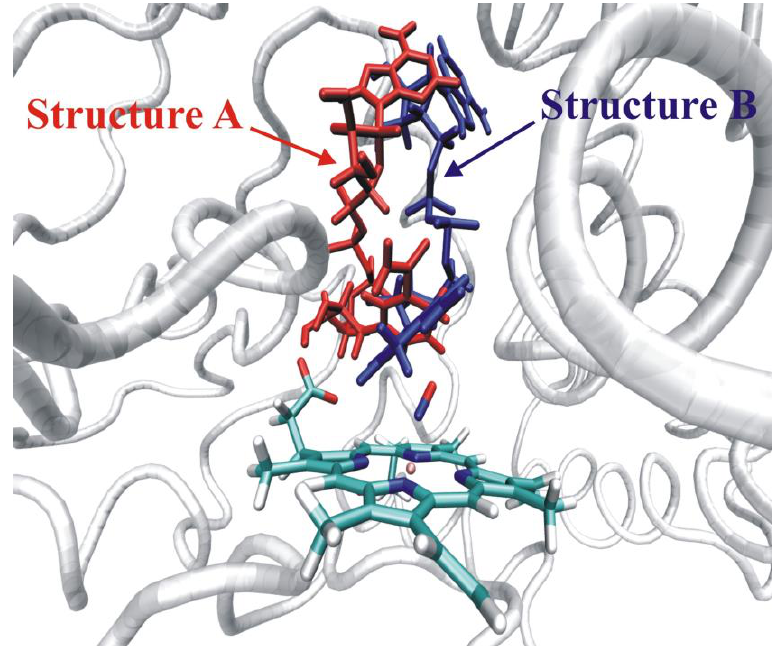
Figure 17. The position of the NADH ligand in the docked structure (structure A ) and in the crystal structure (structure B